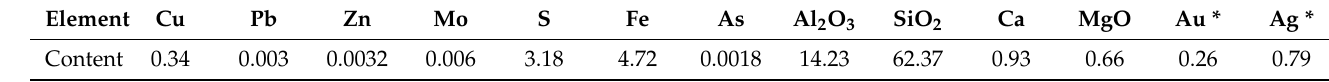
Table 3. Chemical multi-element analysis (%).